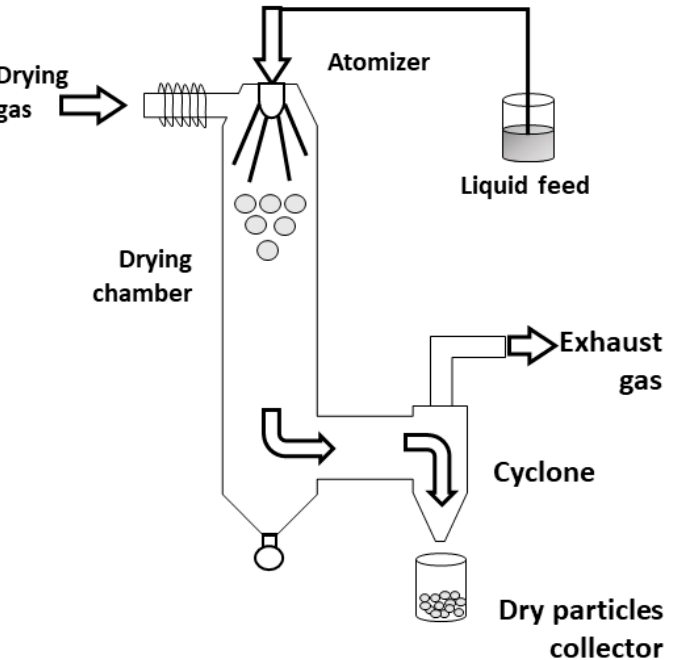
Figure 8. Schematic of spray-drying process. Figure adapted with permission from Sosnik et al. [64].